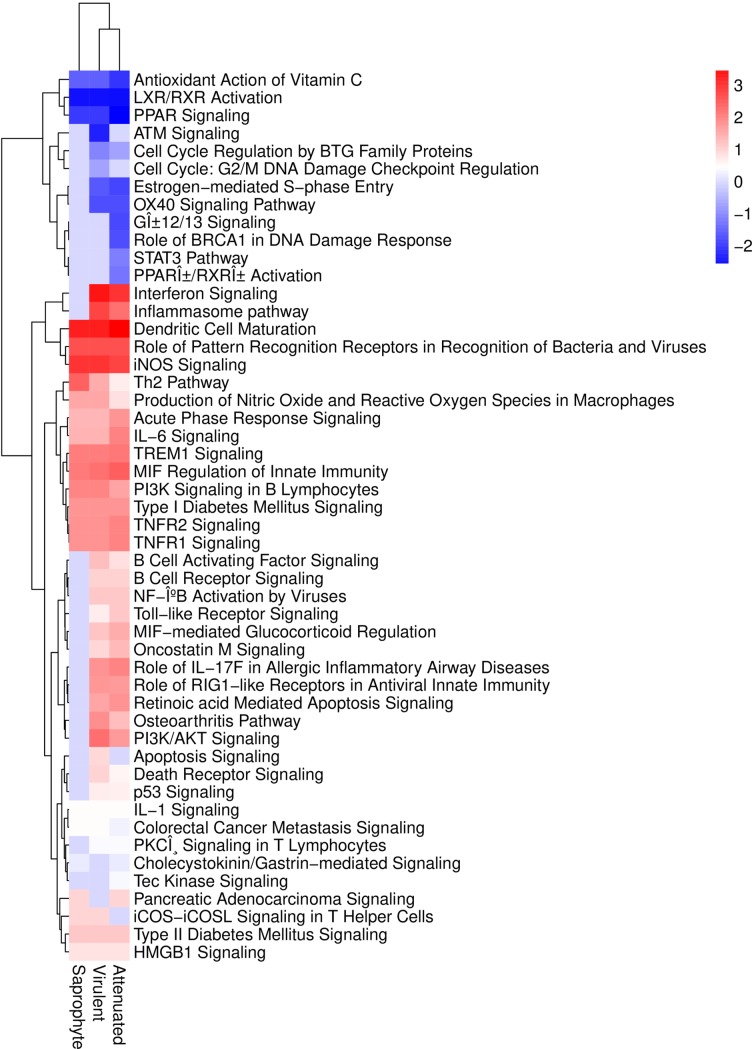
Heatmap of Canonical pathways predicted through z-score to be inhibited or activated in macrophages, at six hours of infection by different strains of Leptospira spp.Activated pathways are plotted in red color and inhibited pathways in blue. (n = 3/treatment; p-value < 0.01).